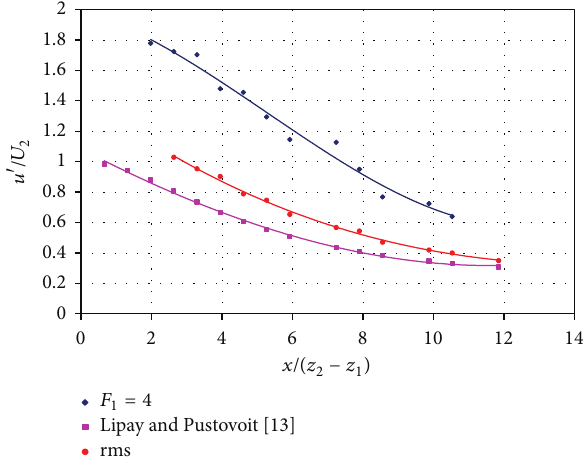
Figure 6: Extreme velocity near the bottom in free hydraulic jump for 𝐹 1 = 4